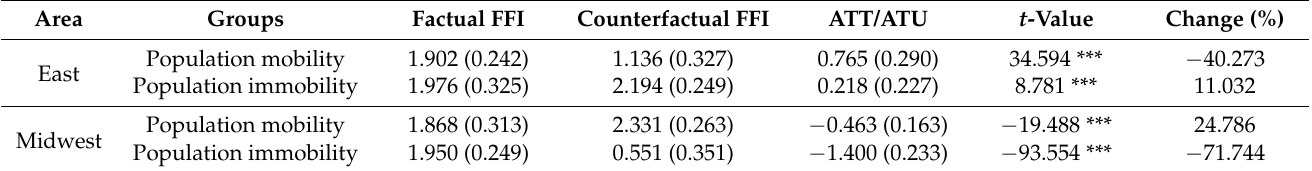
Table 9. The empirical results at the level of